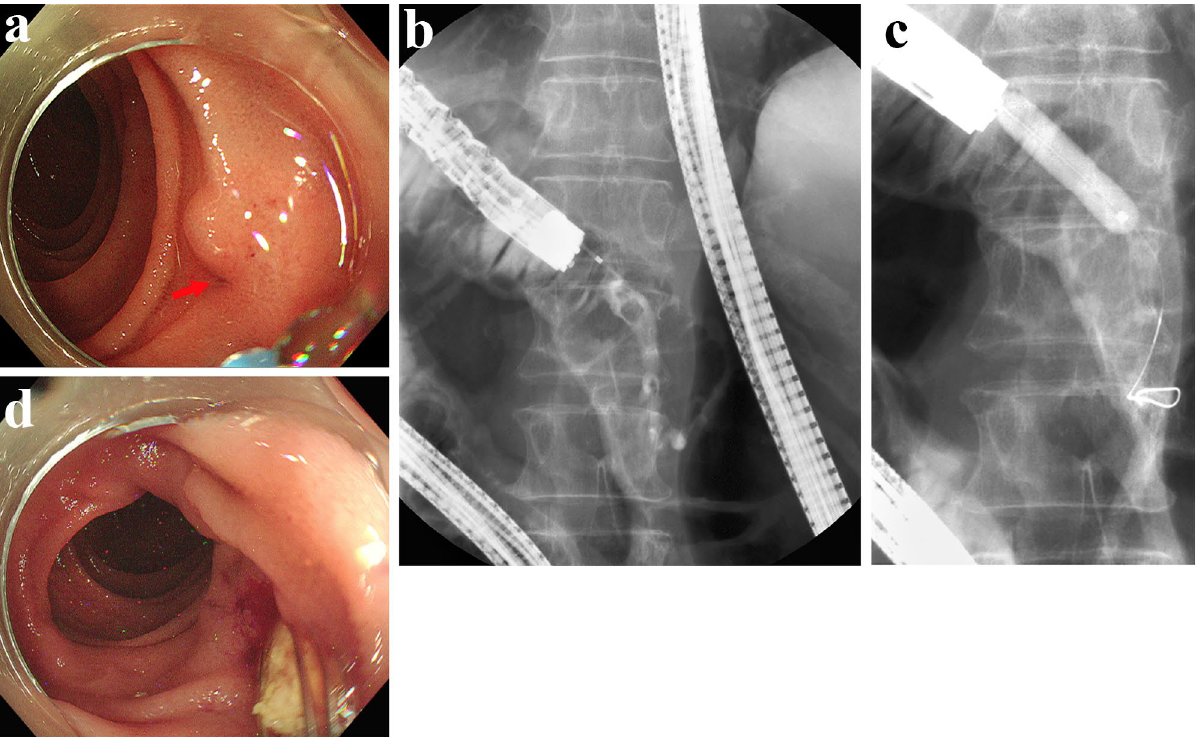
Figure 2. The procedures of endoscopic retrograde pancreatic drainage. ( a ) Endoscopy revealed a pinhole-like opening at the anastomotic site. There were no apparent tumor lesions. The red arrow shows the anastomotic site. ( b ) Two pancreatic calculi were identified in the remnant main pancreatic duct on endoscopic retrograde pancreatography. ( c ) Balloon dilation was performed at the anastomotic site to achieve waist disappearance. ( d ) Pancreatic calculi were removed using